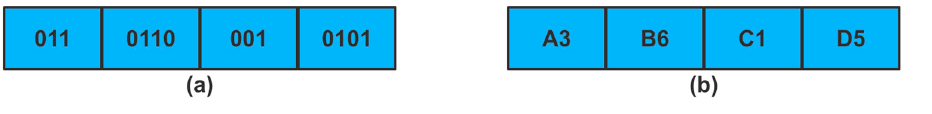
Figure 4. A cluster center (A3,B6,C1,D5) and its corresponding coding scheme: ( a ) the coding scheme of the cluster center; ( b ) the cluster center (A3,B6,C1,D5).